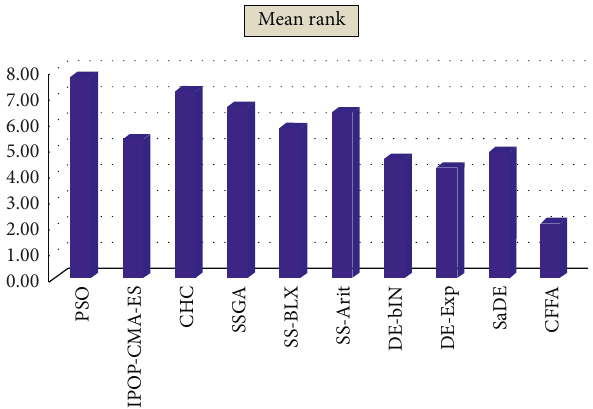
Figure 4: The Friedman test ′ s mean -ranking on CFFA and its 9 Table 5: The results of Wilcoxon ′ s signed-rank test for the 25 CEC ′ 2005 benchmark functions. Test Statistics